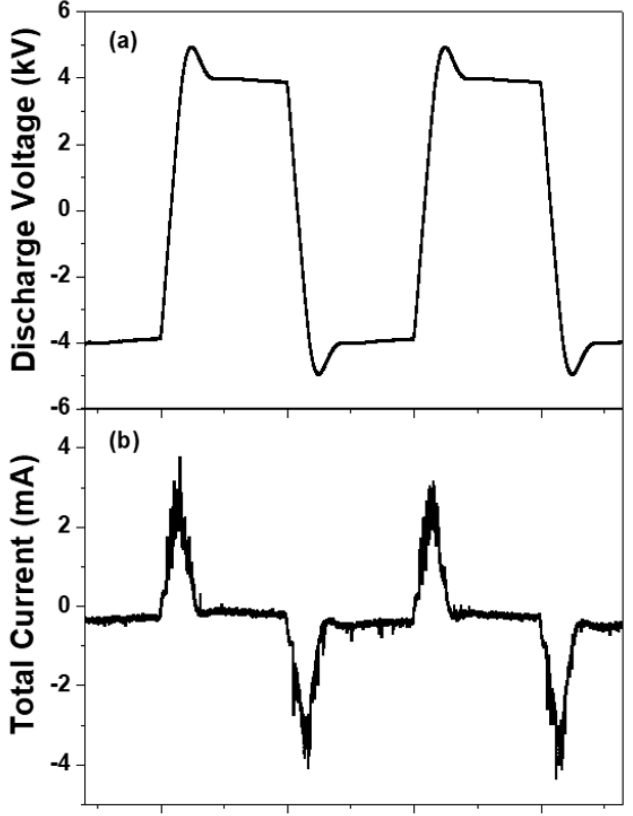
Figure3. Waveformsof( a )dischargevoltageand( b )totalcurrent( = dischargecurrentplusdisplacement Figure 3. Waveforms of ( a ) discharge voltage and ( b ) total current (= discharge current plus current) measured during low temperature DBD between two displacement current) measured during low temperature DBD between two electrodes.